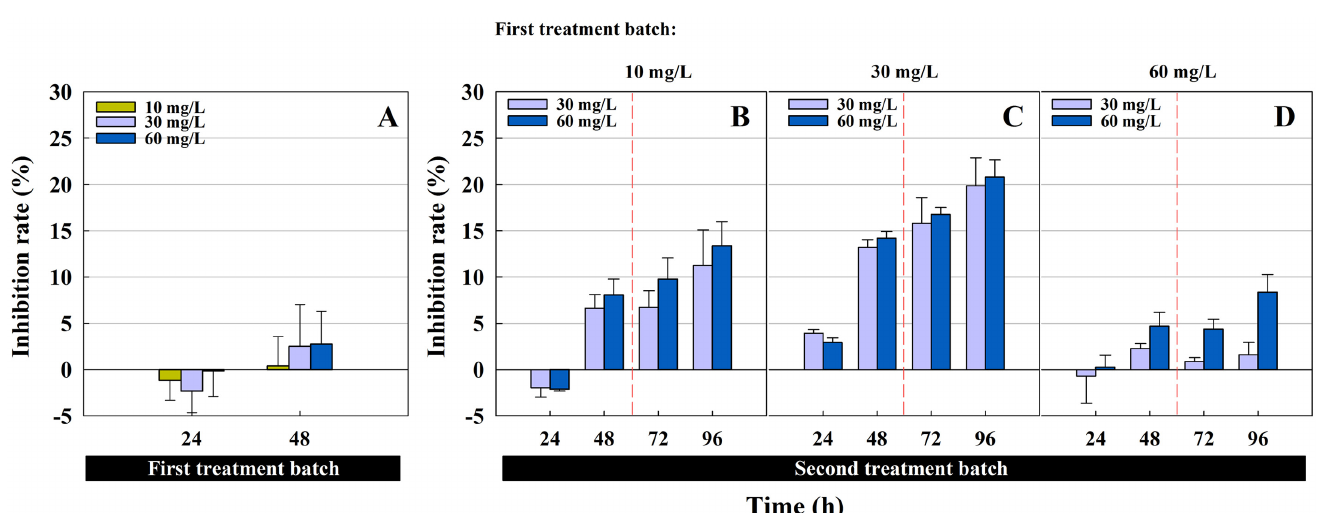
Fig 1. The population growth inhibition rate of C . pyrenoidosa in a sequencing batch reactor alga process (SBAR) to remove cefradine. (A) The inhibition rate in the first treatment batch at three concentrations (10, 30 and 60 mg/L). (B-D): The inhibition rate in the second treatment batch at two concentrations (30 and 60 mg/L) after a first treatment batch at 10 mg/L, 30 mg/L or 60 mg/L.